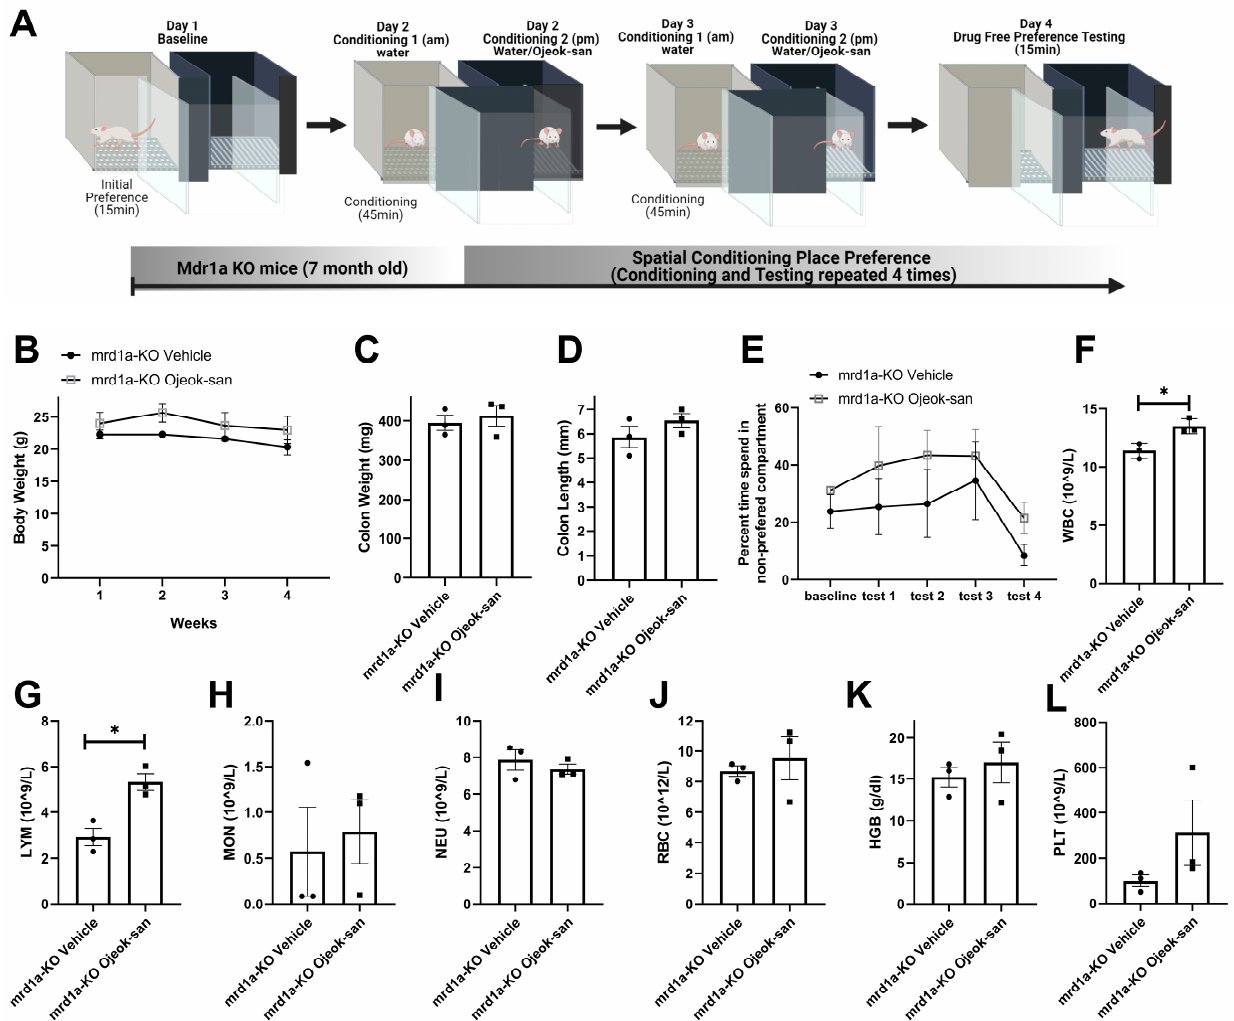
Figure 6. Four-week administration of OJS does not impact disease progression or show rewarding properties in the mdr1a KO mouse model of spontaneous colitis. ( A ) Graphical depiction of spatial conditioning place-preference protocol; ( B ) body weight, ( C ) colon length, ( D ) colon weight, ( E ) per- cent time spend on the OJS-paired side compartment during the test sessions, ( F ) WBC, ( G ) LYM, ( H ) MON, ( I ) NEU, ( J ) RBC, ( K ) HGB, and ( L ) PLT in vehicle- and OJS-treated mrd1a KO mice. Values are represented as mean ± SEM; n = 3 mice per group. Two-way RM AVOVA was conducted for ( A , E ). Two-tail unpaired t -test was conducted for ( C , D ), and ( F – L ). * Indicates statistical significance between groups, p < 0.05.